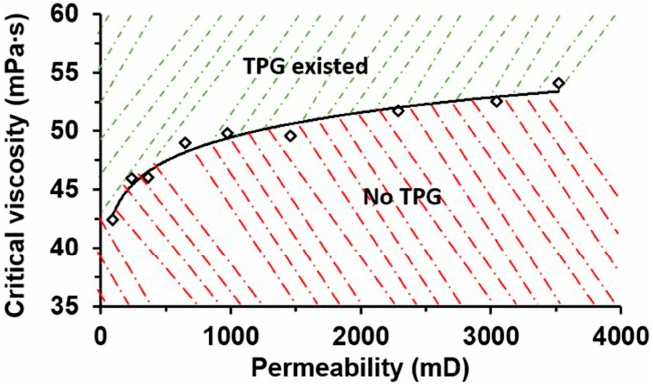
Figure 9. The critical viscosity for a given permeability, above which the TPG existed. Otherwise, the TPG no longer existed.